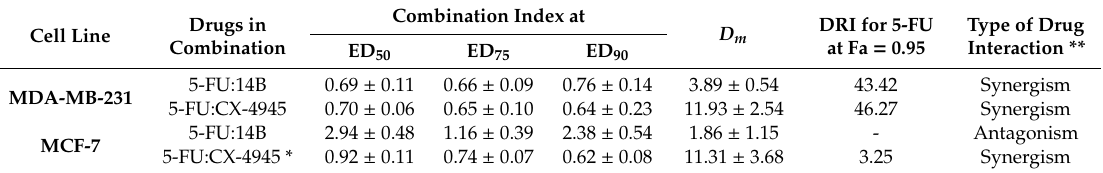
Table 2. Combination index (CI) calculated at e ff ective doses ED 50 , ED 75 , and ED 90 , drug potency ( D m ), and dose reduction index (DRI) for the tested drug combinations for MDA-MB-231 and MCF-7 cells after 72 h treatment. CI values were generated by the CalcuSyn software after fitting fraction a ff ected (Fa) values obtained by the MTT-based assay.